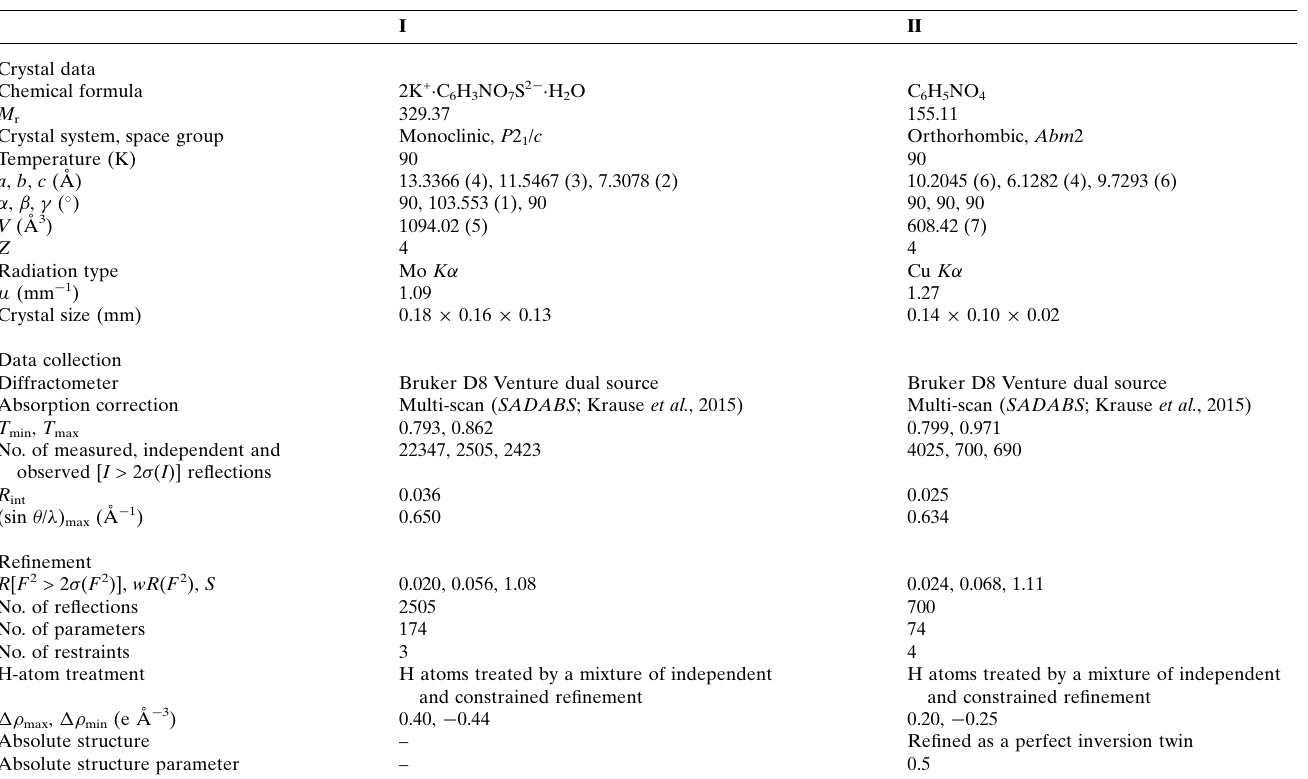
Table 3 Experimental details.